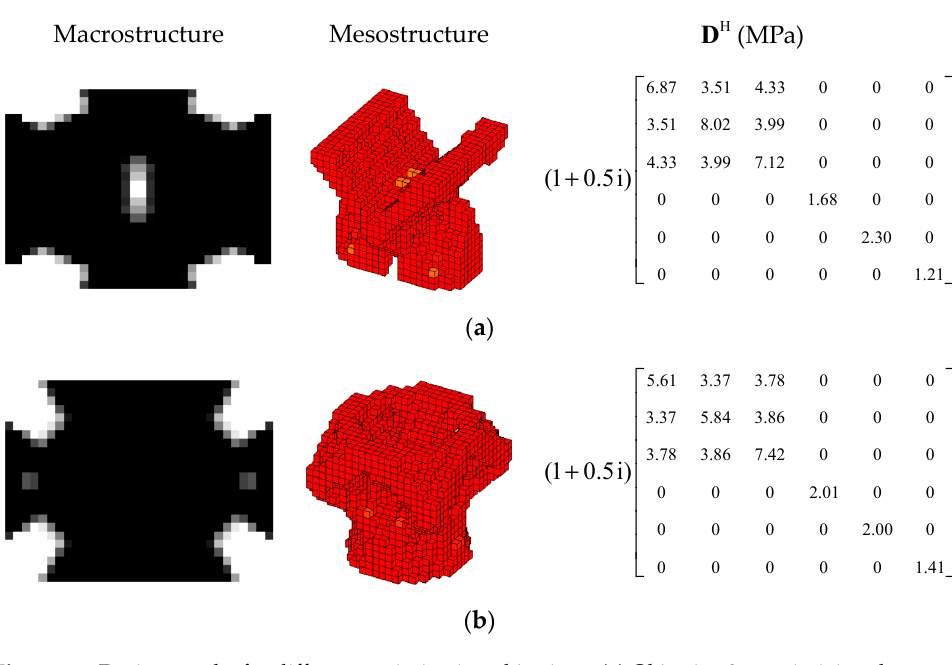
Figure 12. Design results for different optimization objectives: ( a ) Objective 2: maximizing the second modal loss factor; ( b ) Objective 3: Maximizing the sum of the first two modal loss factors.